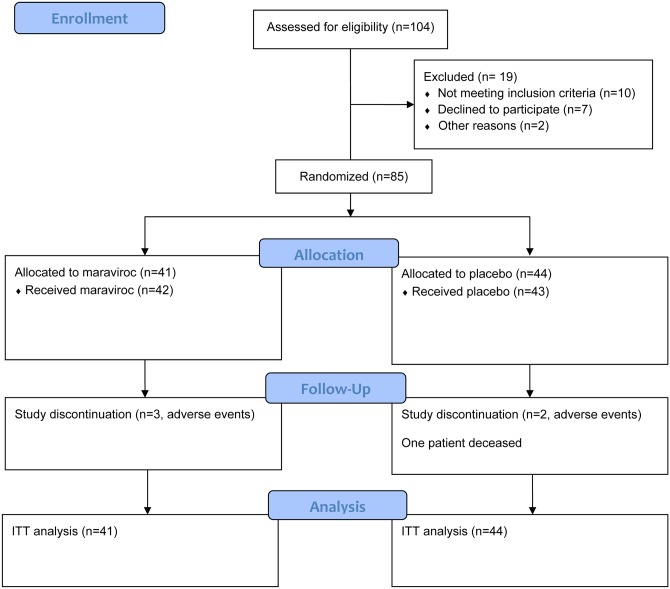
CONSORT 2010 flow diagram of the study population.One hundred and four patients were screened, of whom 85 were included in the study. One patient was mistakenly treated with MVC instead of placebo during the entire study and an intention-to-treat analysis was performed. One participant deceased (in the placebo arm) whereas 5 participants prematurely discontinued the study (at week 2, 13, 18, 29 and 42); 79 study participants finished the complete study protocol. Data of all participants were included in the analysis of the primary endpoint.